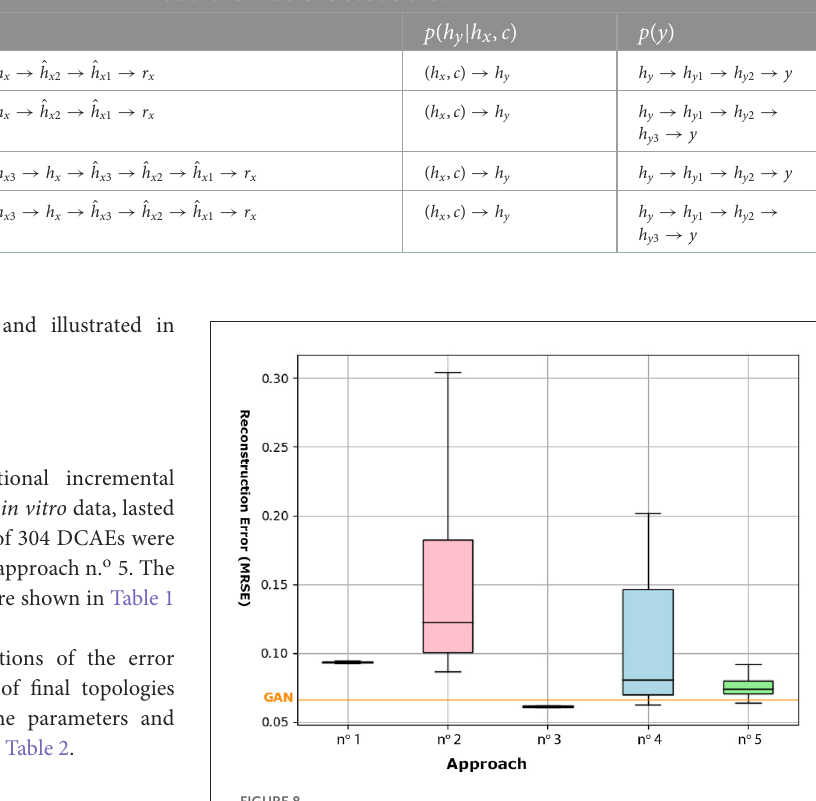
Sub-architecture associated with: